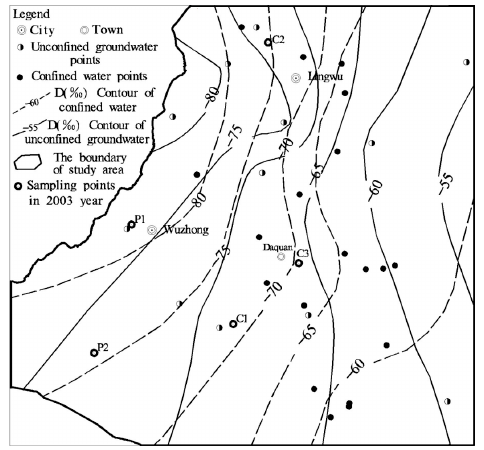
Figure 7. Contour lines of groundwater δ D (‰).